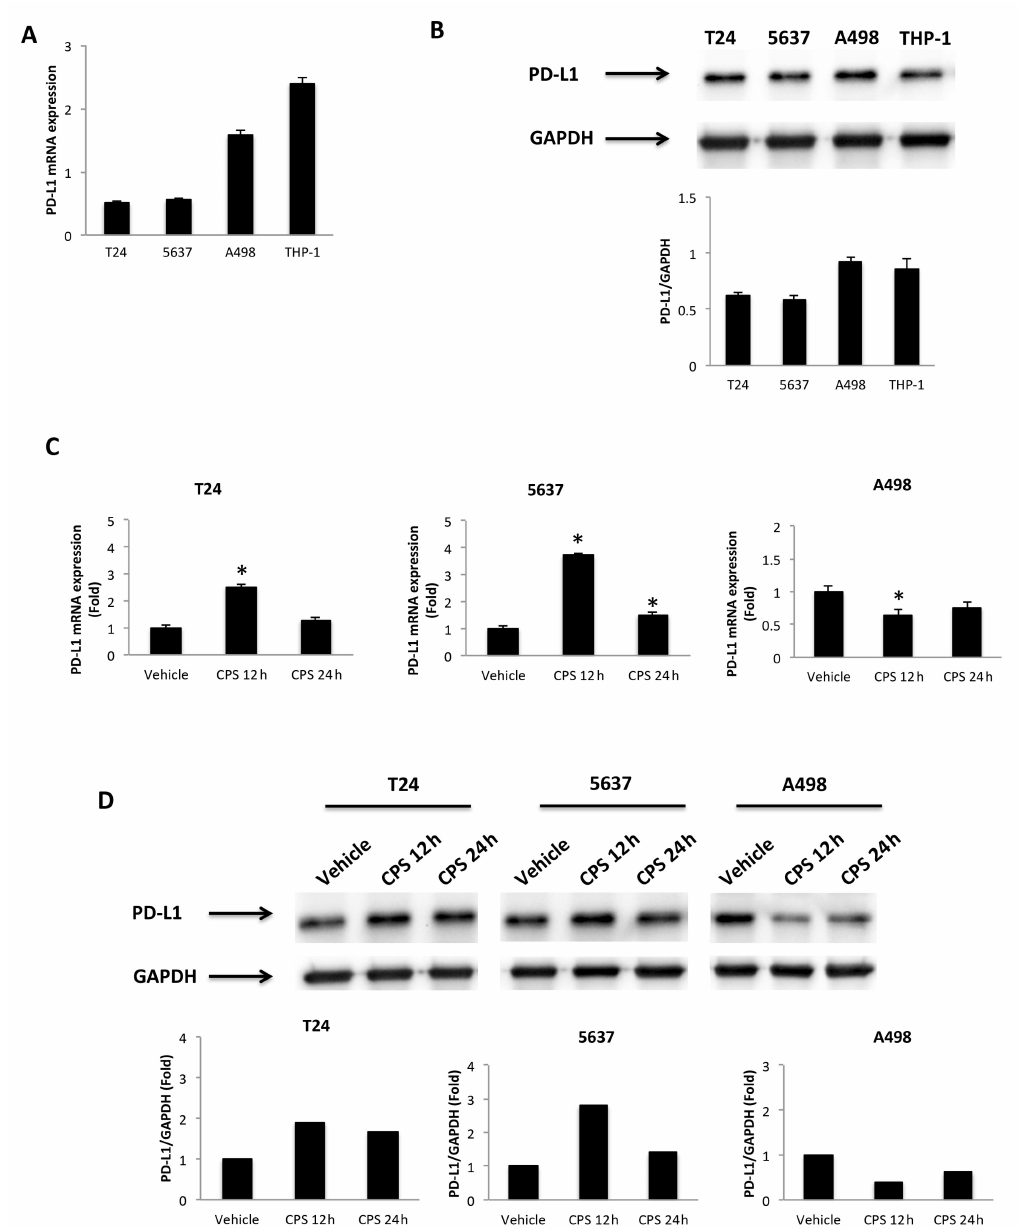
Figure 2. CPS treatment influences PD-L1 expression. ( A ) The relative PD-L1 mRNA expression in T24, 5637, A498 and THP-1 (positive control) cell lines was evaluated by qRT-PCR. PD-L1 mRNA levels were normalized for GAPDH expression. Data are expressed as mean ± SD. ( B ) Western blot analysis of PD-L1 protein levels. Blots are representative of one of three separate experiments. PD-L1 densitometry values were normalized to GAPDH, used as the loading control. Data are expressed as mean ± SD. ( C ) PD-L1 mRNA expression in T24, 5637 and A498 cell lines treated with 50 µ M CPS for 12 and 24 h was evaluated by qRT-PCR. PD-L1 mRNA levels were normalized for GAPDH expression. Data are expressed as mean ± SD; * p < 0.05. ( D ) Western blot analysis of PD-L1 protein expression in T24, 5637 and A498 cell lines treated with 50 µ M CPS for 12 and 24 h. Blots and densitometry values are representative of one of three separate experiments. PD-L1 densitometry values were normalized to GAPDH, used as the loading control. The PD-L1 protein levels of treated cells were determined with respect to PD-L1 levels of vehicle-treated cells. Detailed information about the Western blotting can be found in Figure